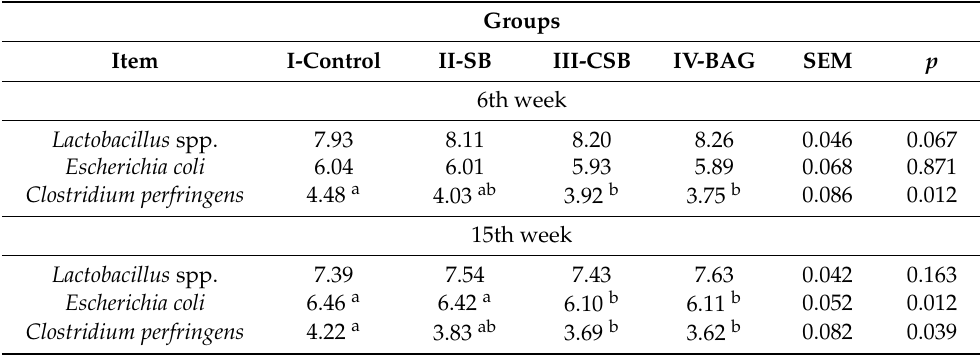
Table 8. Effect of butyric acid on the fecal microbiota (log 10 CFU/g) in turkeys.